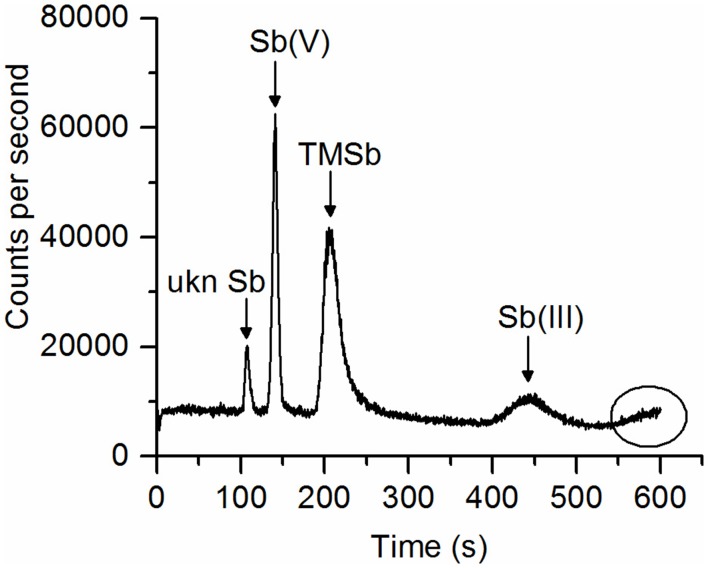
Chromatogram of a ryegrass root sample extract showing a peak of an unknown Sb species (ukn Sb) before the peaks of Sb(V), TMSb, and Sb(III) appeared. At the end of measurement, a broad peak tended to elute.